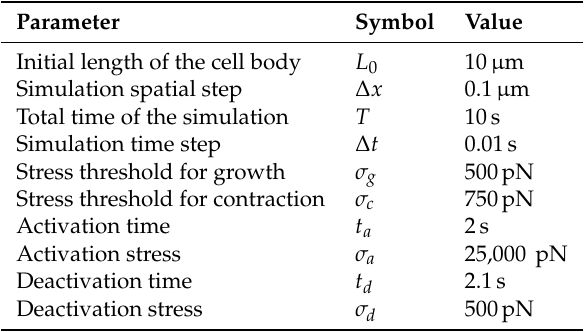
Table 2. Numerical values for the parameters of the